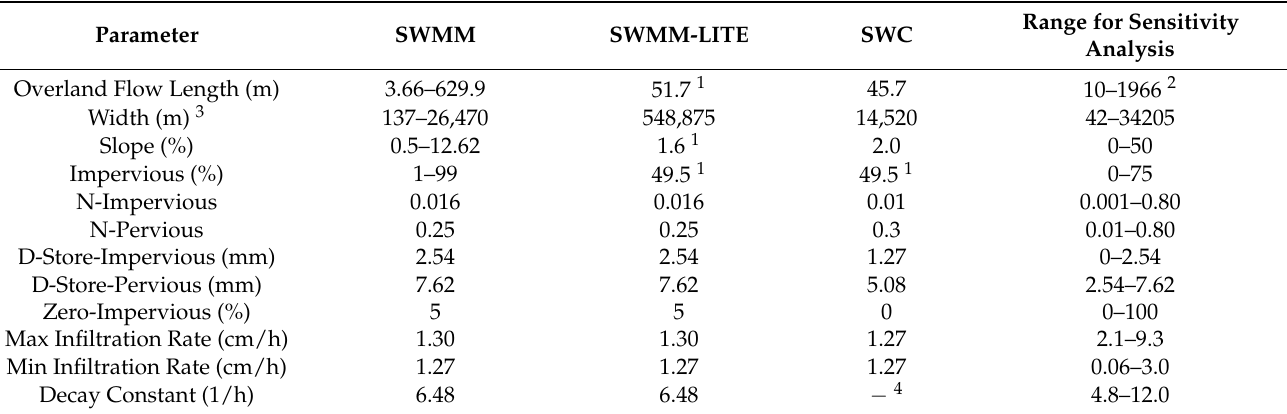
Table 2. Input parameters applied to tested models and for sensitivity